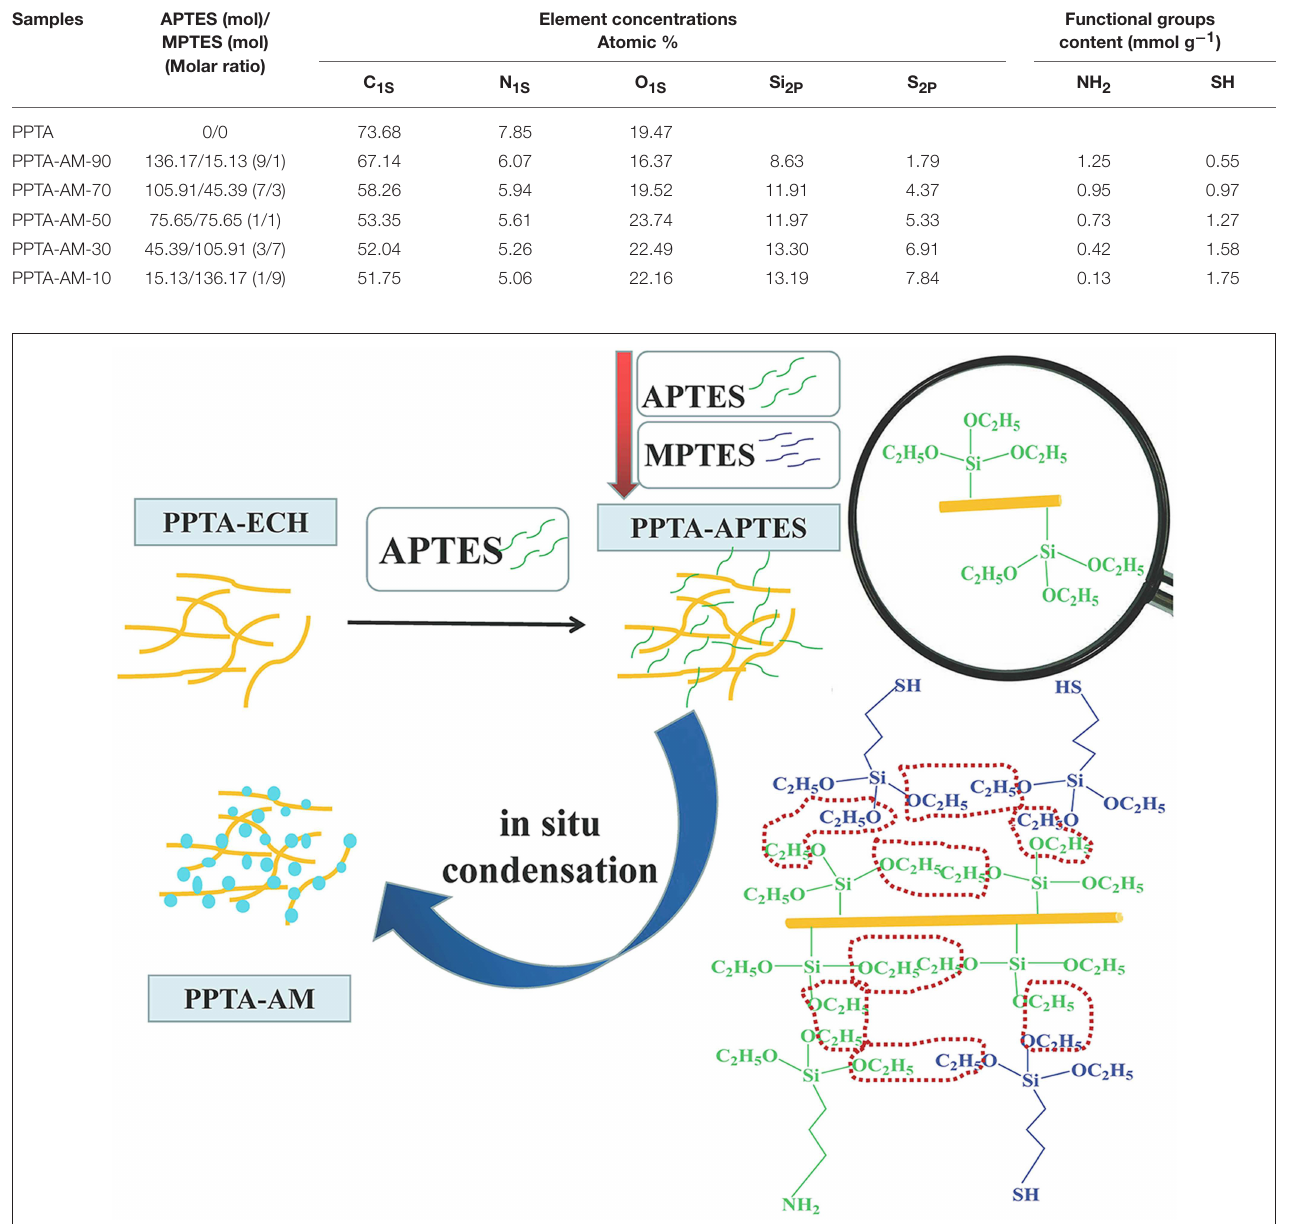
TABLE 1 | Formulations, element concentrations and binding energies of N 1s , S 2p , and Si 2P of PPTA and PPTA-AM samples.